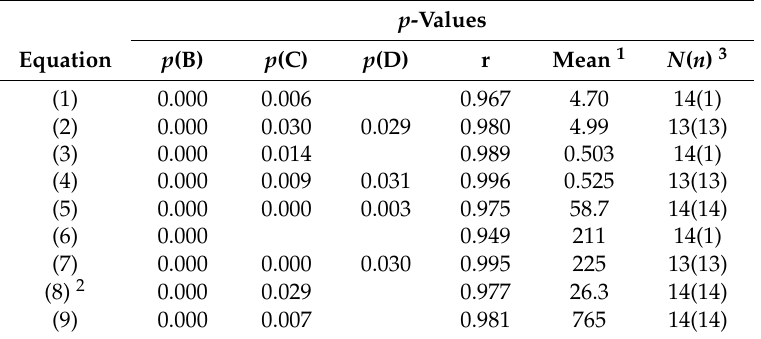
Table 3. Statistics of linear equations for the prediction of aqua-regia-extractable contents of trace metals (X(pred)) from the readings (soil and mining methods) obtained using pXRF on the compost samples. p